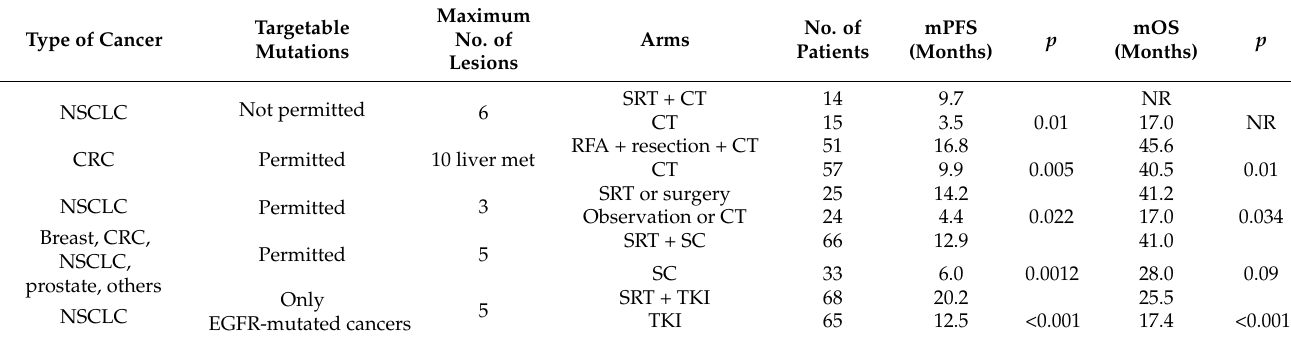
Table 2. Randomized trials including SRT treatment in